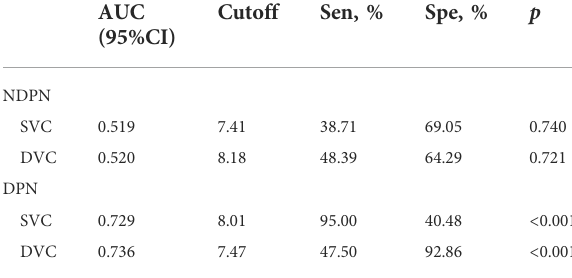
TABLE 3 ROC curve analysis of VLD in different layers of DM with or without